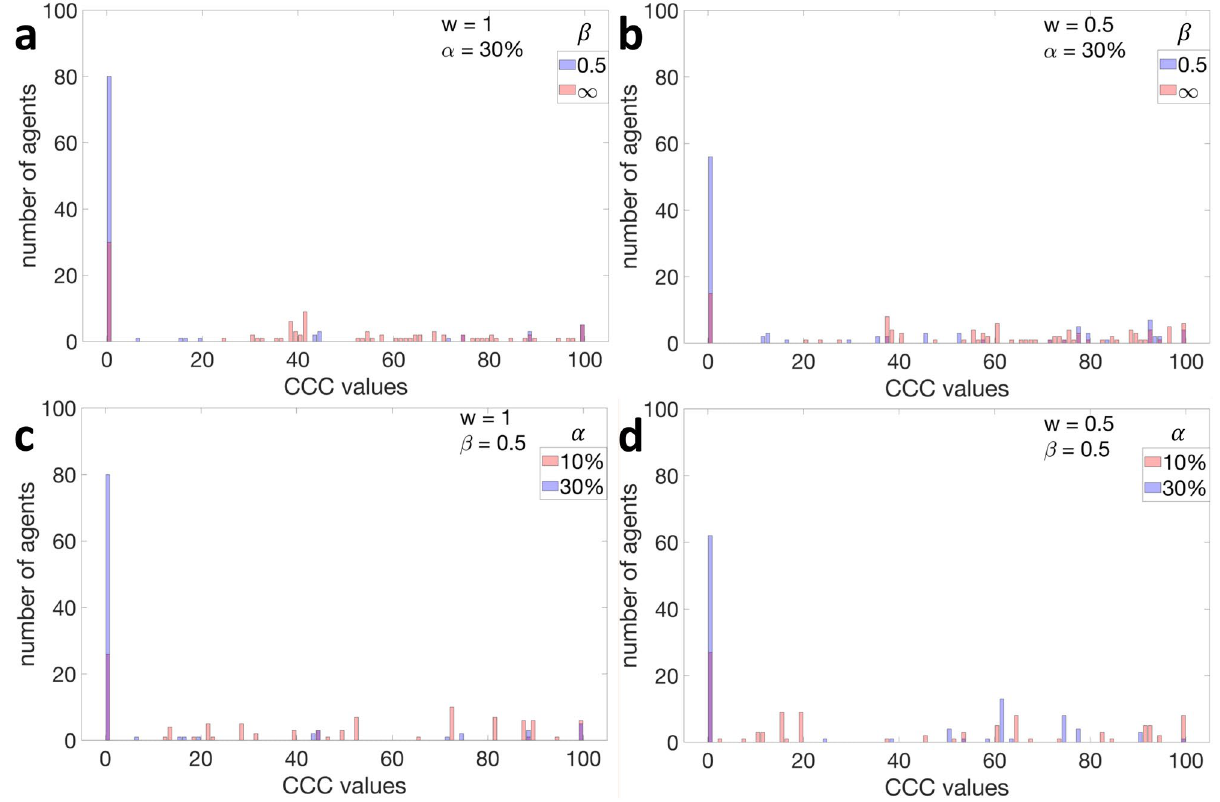
Figure 3. Distribution of the conditional cooperative criterion (CCC) values. Every altruists is born into the initial population with a conditional cooperative criterion CCC i = 0 , while every conditional cooperator k is born with CCC i ∼ { 0, . . . , N } . The figure depicts the distribution of all CCC values in the 20,000th generation for different percentages of altruists ( α ), different levels of noise ( β ), and different values of w . a , Results when α = 30% , β ∈ { 0.5, ∞} , and w = 1 . b , The same as ( a ) but for w = 0.5 instead of w = 1 . c Results when α ∈ { 10%, 30% } , β = 0.5 , and w = 1 . d , The same as ( c ) but for w = 0.5 instead of w = 1